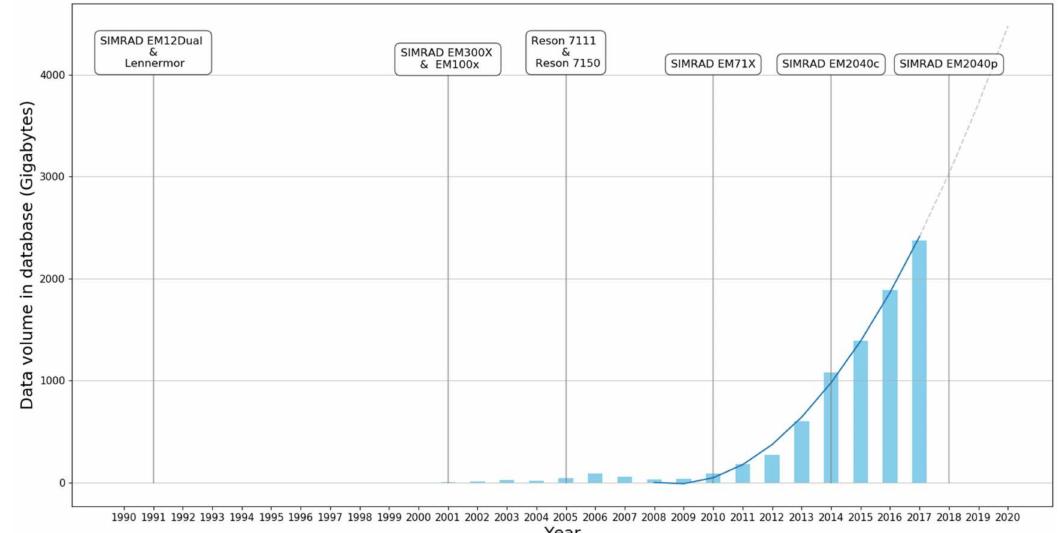
Figure 1. Volume of post-processed bathymetric data at Shom between 1991 and 2017. The last three years are missing due to the time required to integrate MBES data in the bathymetric